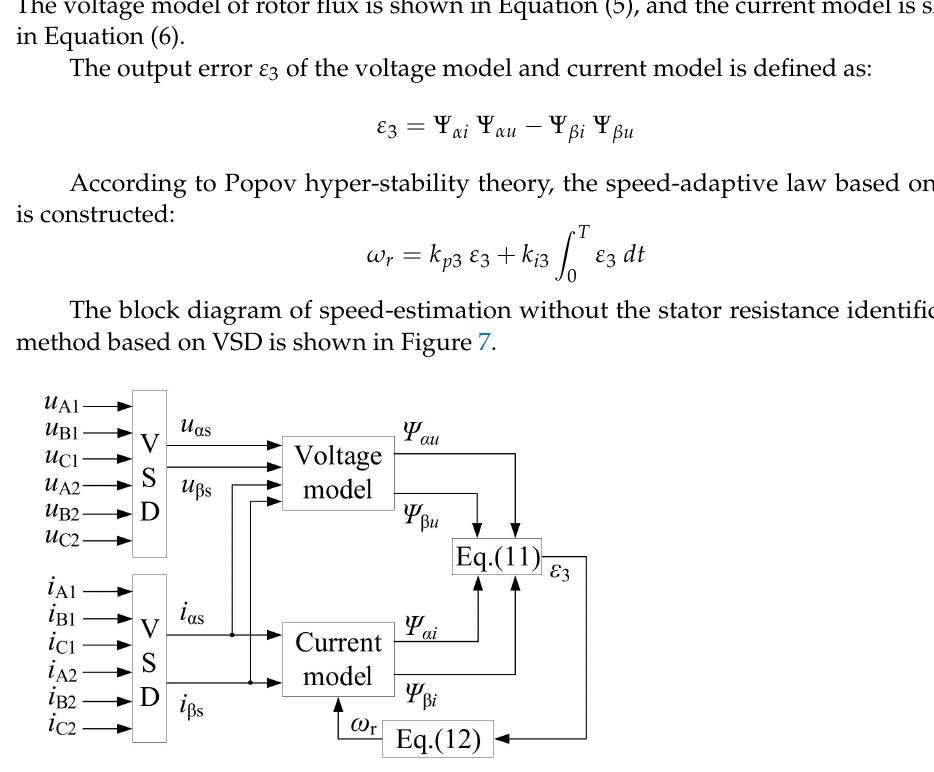
Figure 7. The block diagram of speed-estimation based on